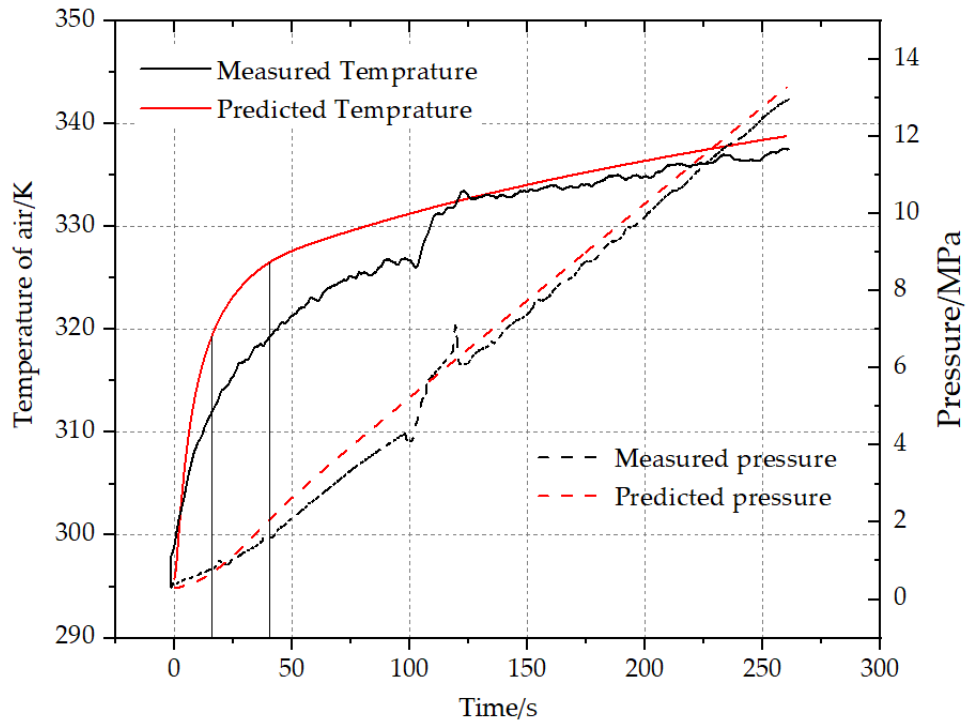
Figure 6. Measured and predicted temperature evolution.